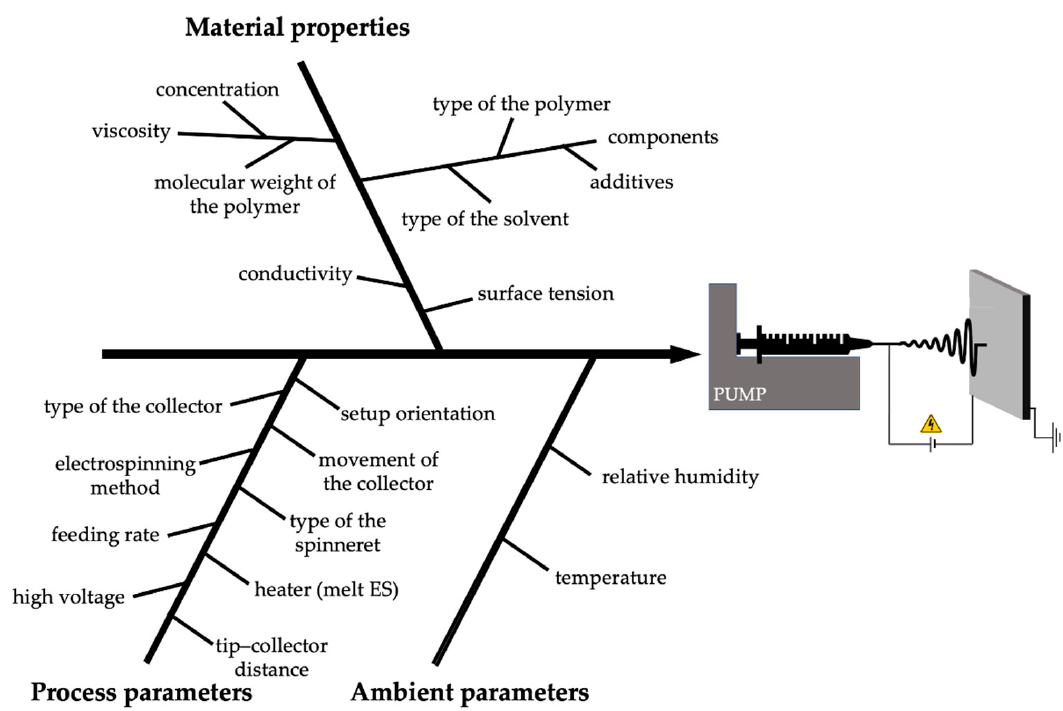
Figure 4. The most important parameters affecting the feasibility of nanofiber production by the electrospinning method.